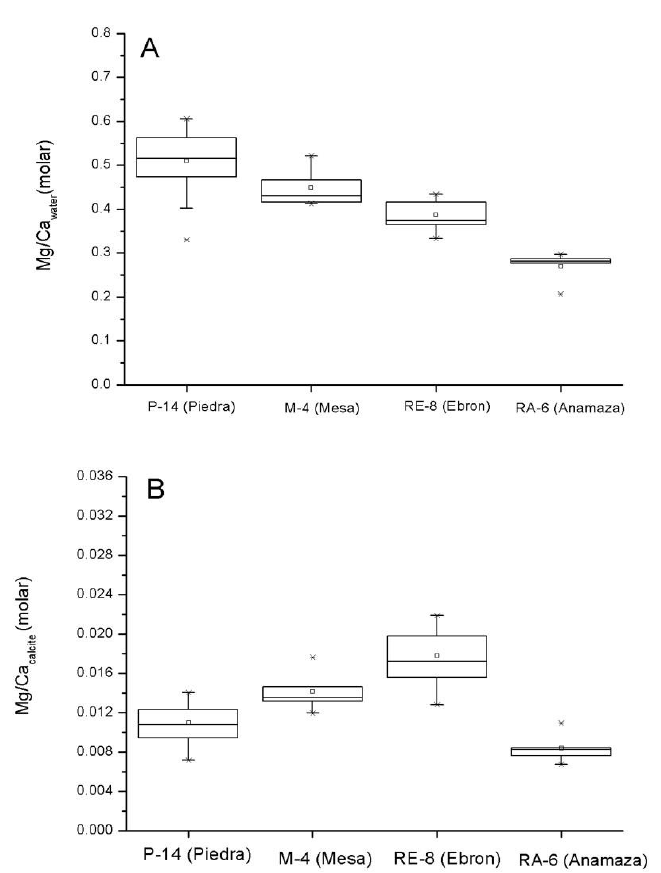
Figure 5. Box-and-whisker plots of statistical distributions of the Mg/Ca values in ( A ) waters and ( B ) stromatolites at studied sites in rivers. Statistical measures plotted are median (horizontal line inside the box), the 25 th and 75th percentiles (bottom and top of the box respectively), mean (square), the 5 th and 95 th percentiles (“whiskers”), the 1 st and 99 th percentiles (crosses) and the maximum and minimum values (horizontal bars).